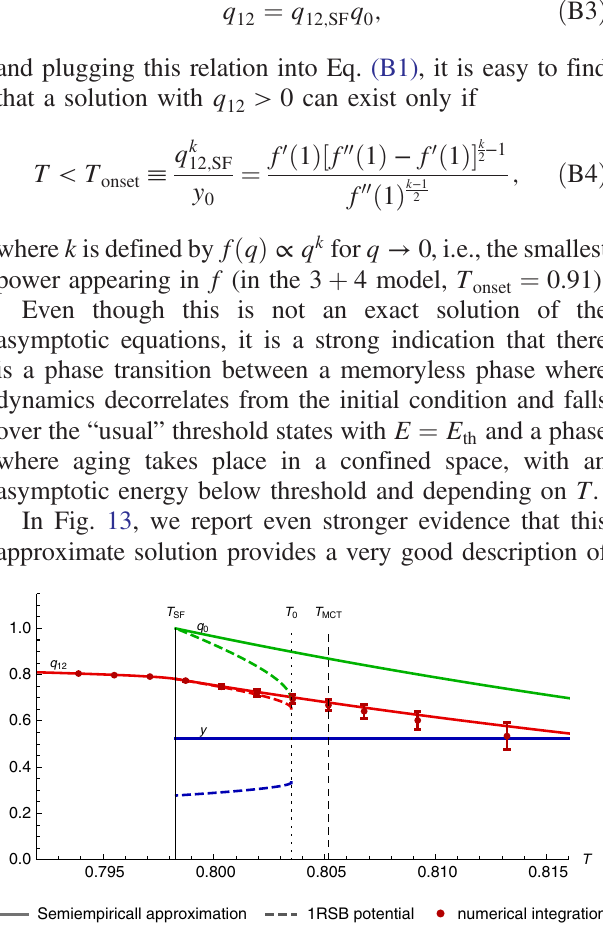
FIG. 13. Comparison between asymptotic aging parameters extrapolated from the numerical solution of the dynamical equations (data with errors), the analytical prediction obtained via the semiempirical approximation derived in Appendix B (solid curves), and the standard RSB aging solution derived in Appendix A (dashed